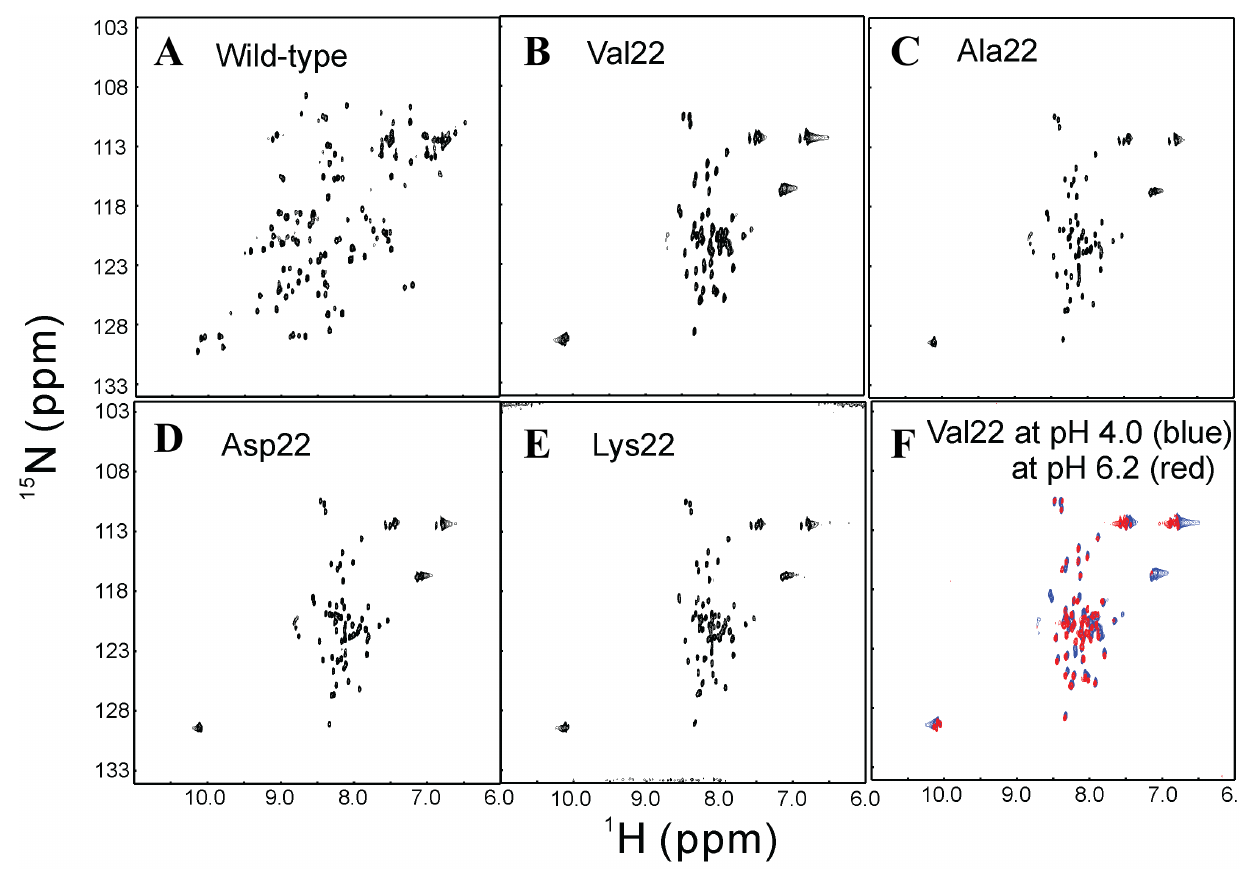
Figure 8. NMR characterization of different forms of the SH3 domain. 1 H– 15 N NMR HSQC spectra of the wild-type SH3 and its four insertion mutants at protein concentrations of 100 µM acquired. The wild-type SH3 was dissolved in 5 mM phosphate buffer (pH 6.2) while four insertion mutants were solubilized in unsalted water (pH 4.0). (F). Superimposition of HSQC spectra of V22-SH3 in unsalted water at pH 4.0 (blue) and at pH 6.2